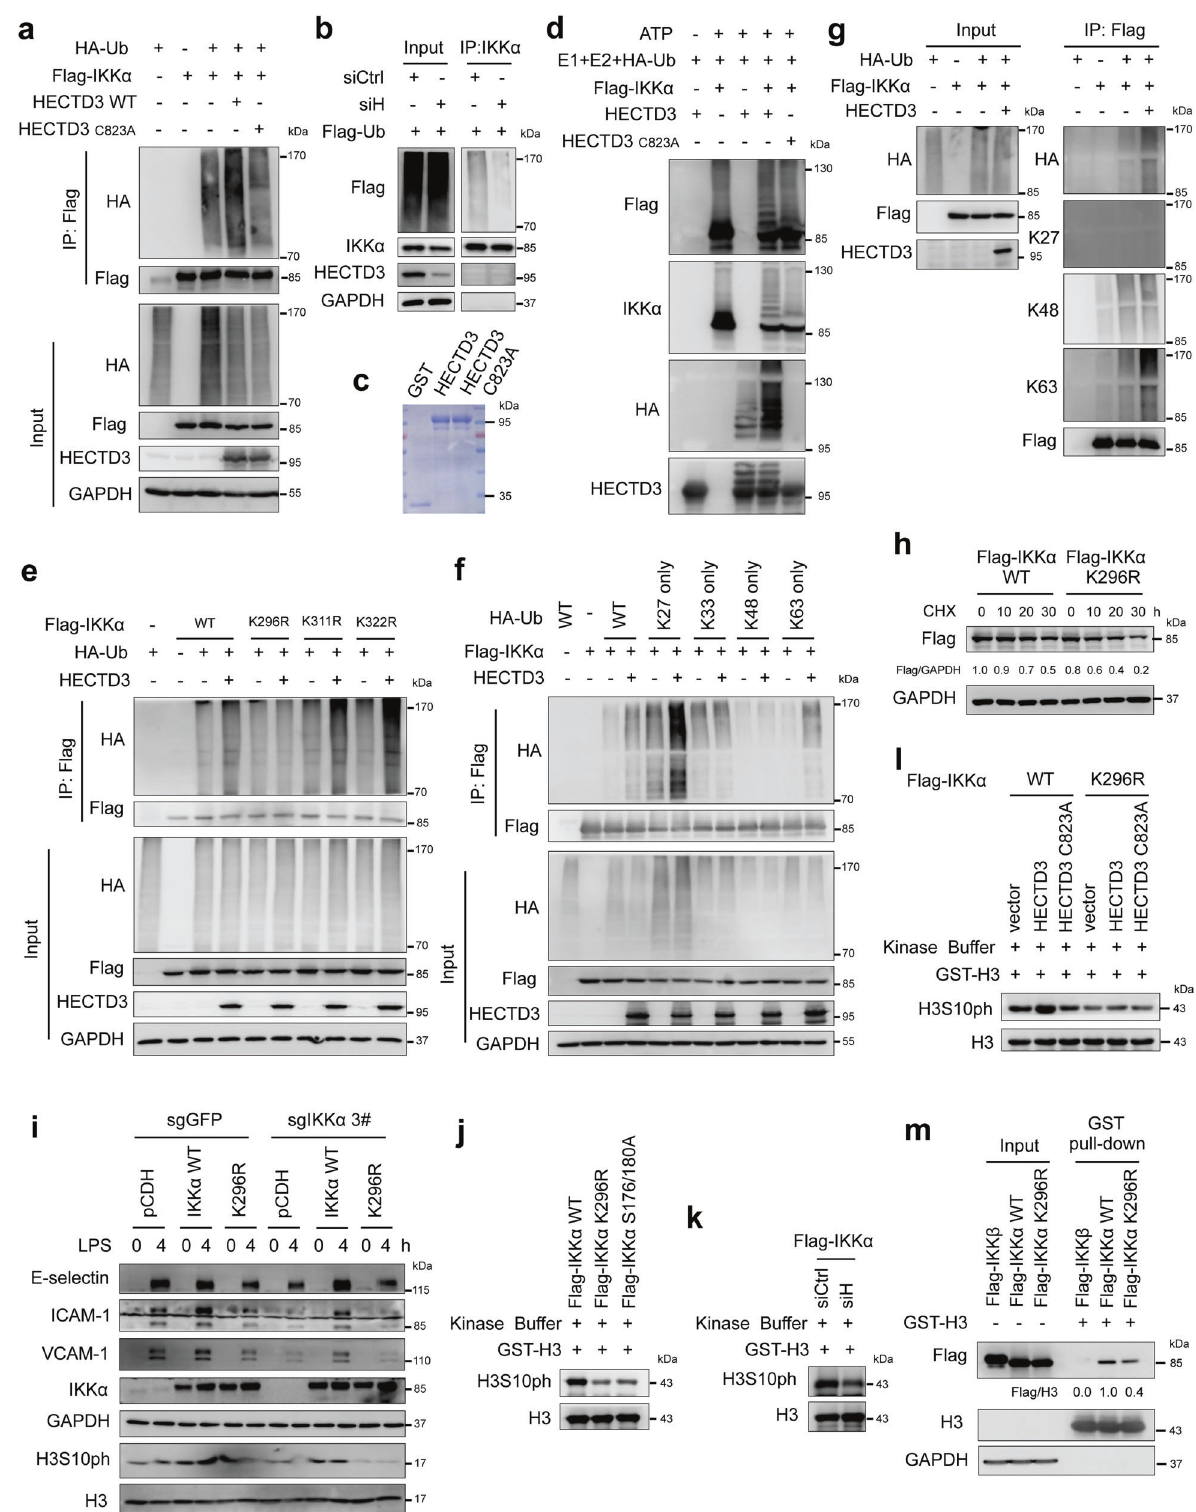
con fi rmed this result by digesting the lung tissues of WT and Hectd3 − / − mice and performing fl ow cytometry analyses. We detected the number of GFP-labeled tumor cells in the lungs in a time course experiment and found that, at 10 min after injection, the number of GFP-positive tumor cells in the lungs of Hectd3 − / −